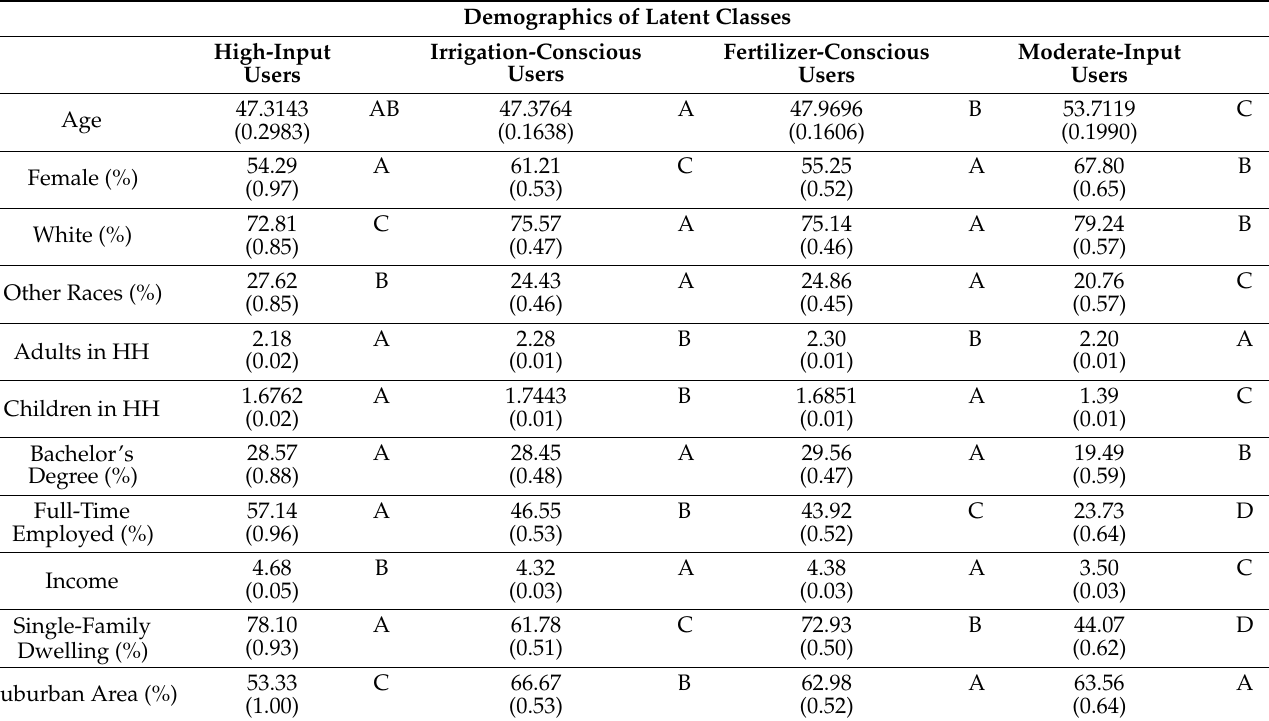
Table 4. Pairwise mean comparison of demographic characteristics for the four classes of